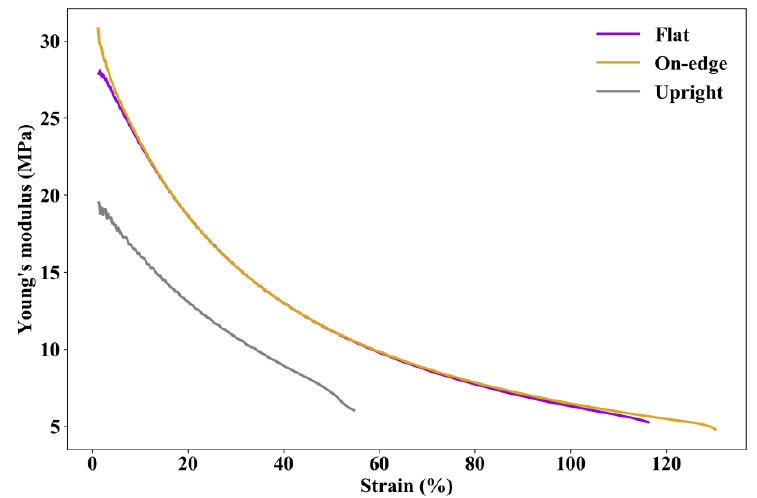
ff erent strains of specimens printed in di ff erent Figure 10. Moduli at different strains of specimens printed in different orientations. Figure 10. Moduli at di